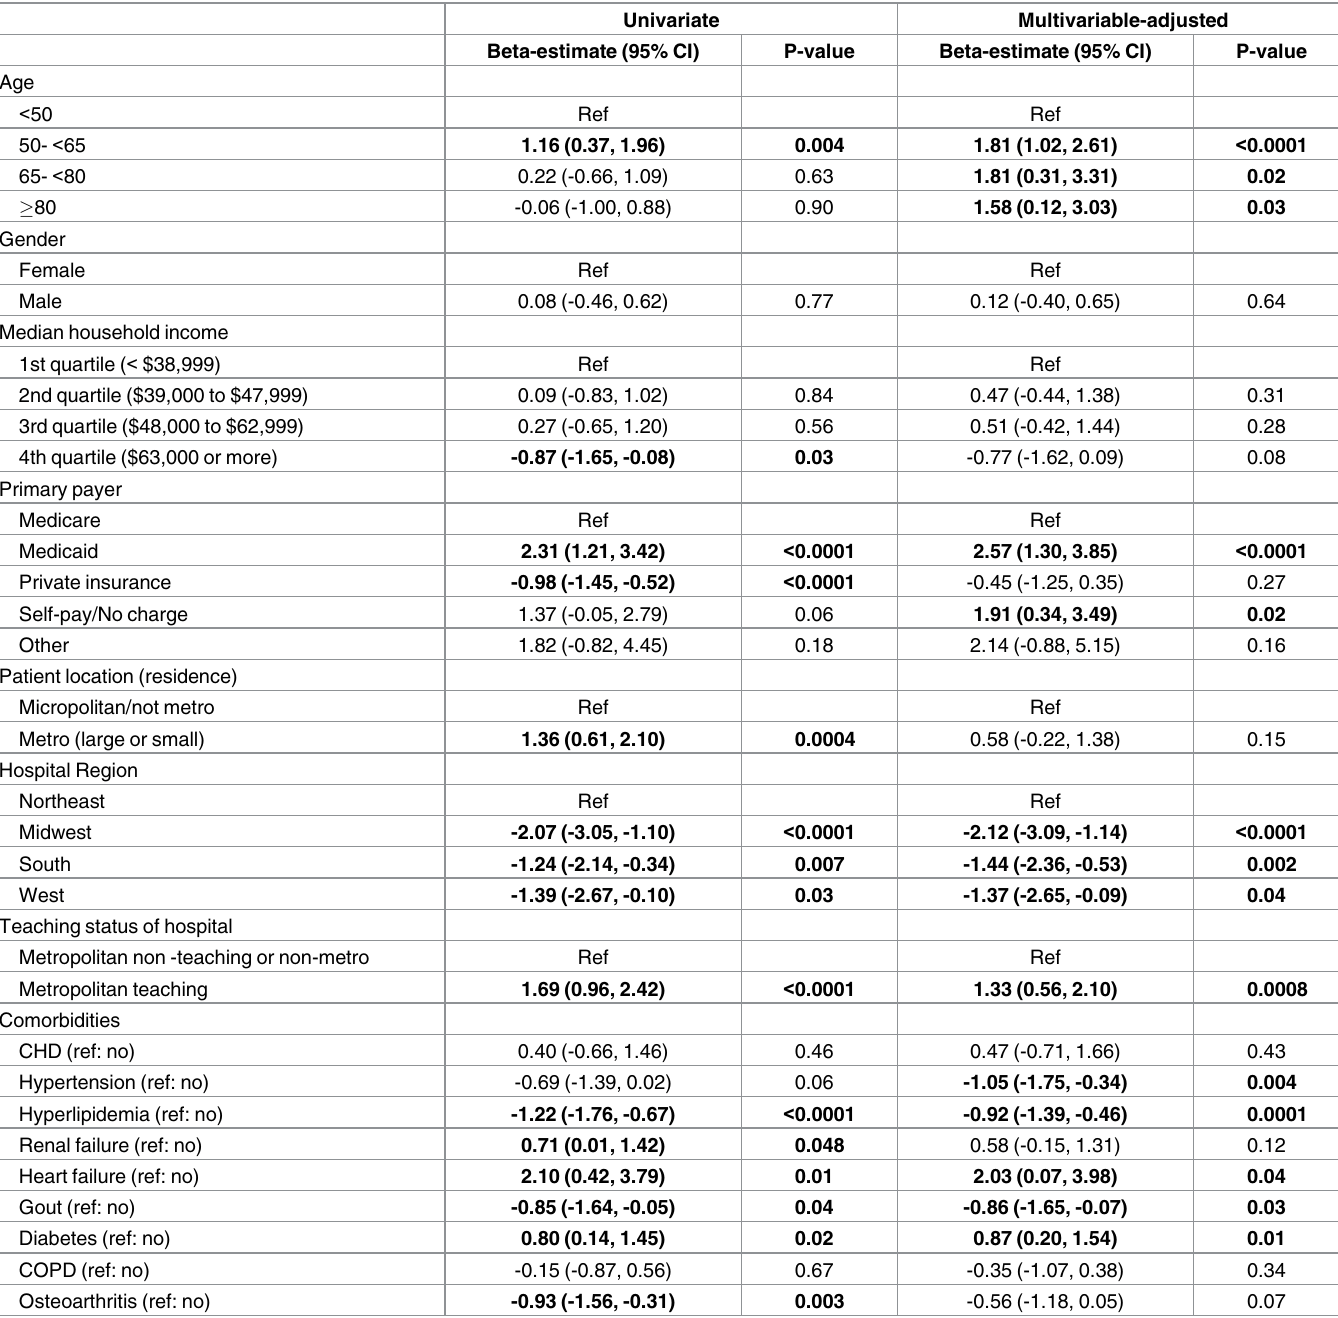
Table 4. Predictors of the duration of hospital stay among patients with septic arthritis hospitalized with septic arthritis after presenting to the